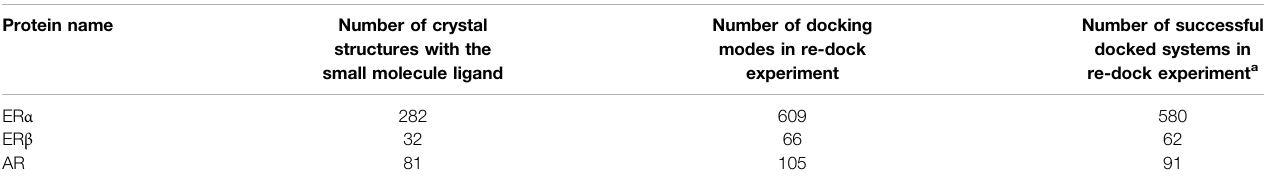
TABLE 1 | Number of structures and docking models for ER α , ER β , and